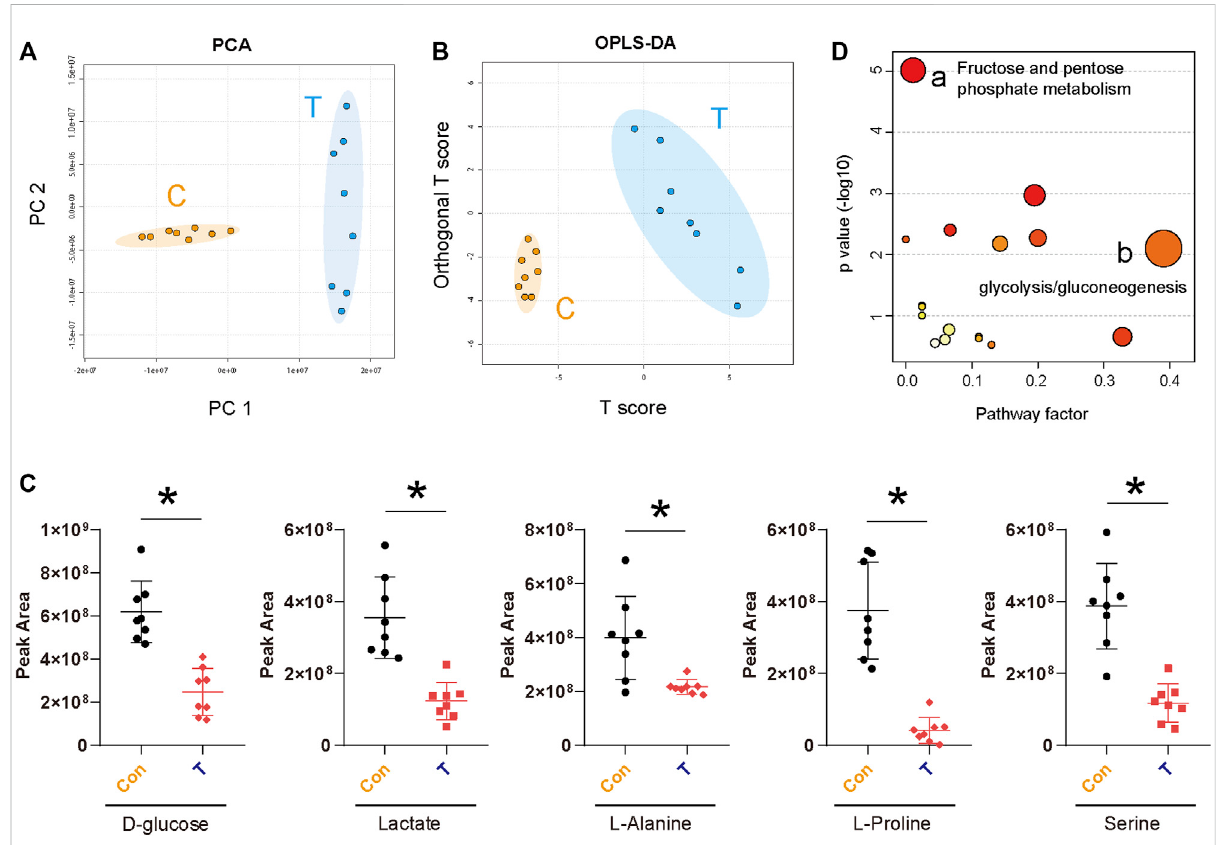
FIGURE 5 STAaffectstheglucosemetabolismpathwayofHep3Bcells. (A) ThePCAscoreplotofControlandDruggroup(30 μ M),itrepresentssamplesin the groups were closely cluster to one another. (B) The OPLS-DA score plot of Control and Drug group revealed the clustering of samples in the training set. (C) Metabolites altered by STA treatment in Hep3B cells. n = 8 replicates per group. (D) Pathway enrichment of differential metabolites. Mainly enriched in fructose and pentose phosphate metabolism and